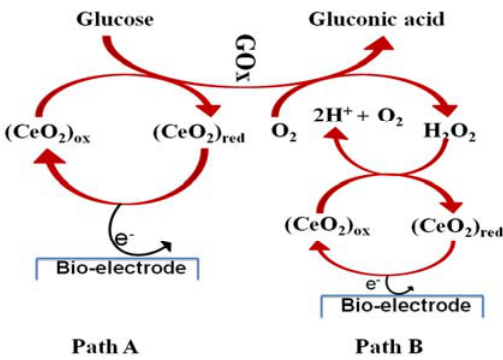
Figure 6. Schematic illustration of two possible biochemical reaction mechanisms on the GOx/CeO /Pt electrode (redrawn from reference 2